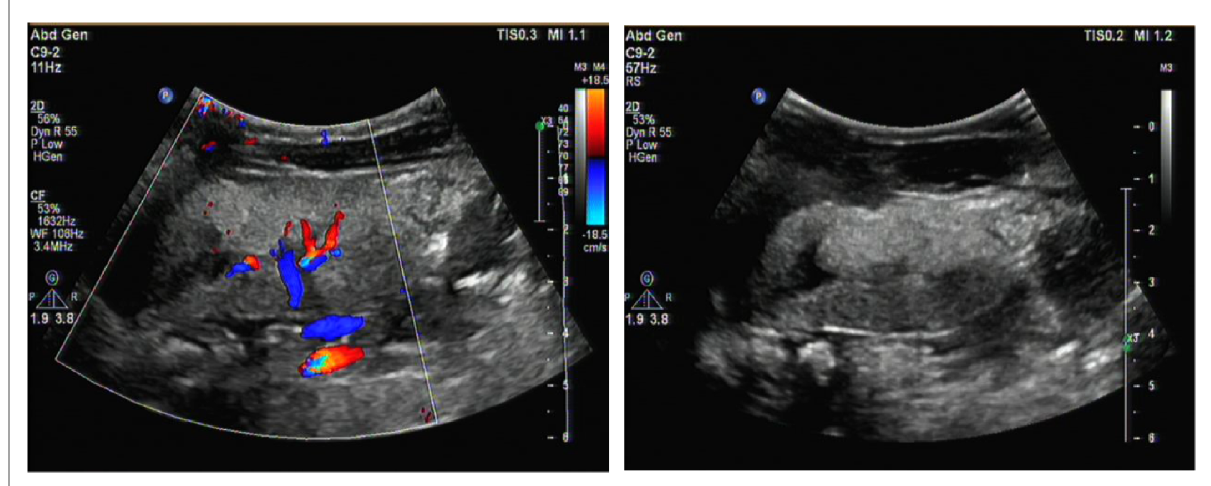
FIGURE 1 Renal ultrasound image. It revealed enhanced echoes of the parenchymaand, and unclear boundary between medulla and cortex of the bilateral kidneys as well as enlargement of both